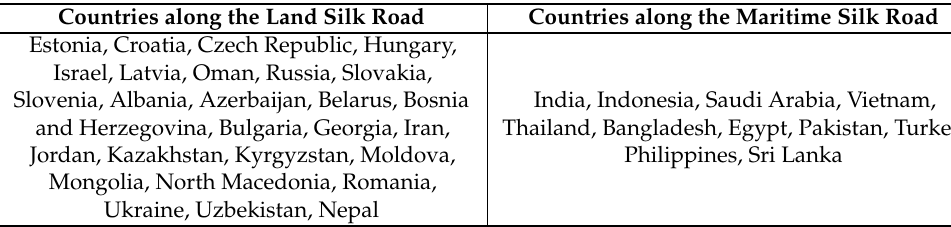
Table 1. 38 countries along the Belt and Road covered in this